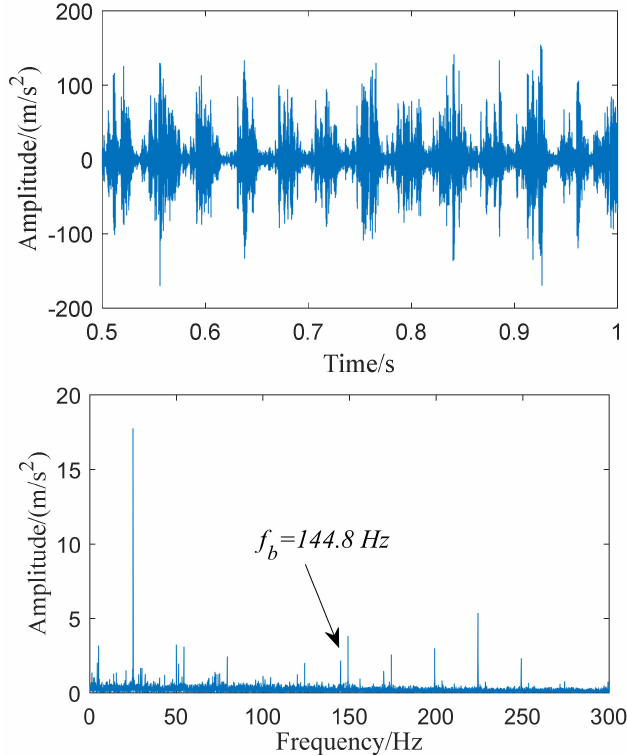
Figure 18. Time–domain signal and envelope spectrum of roller fault